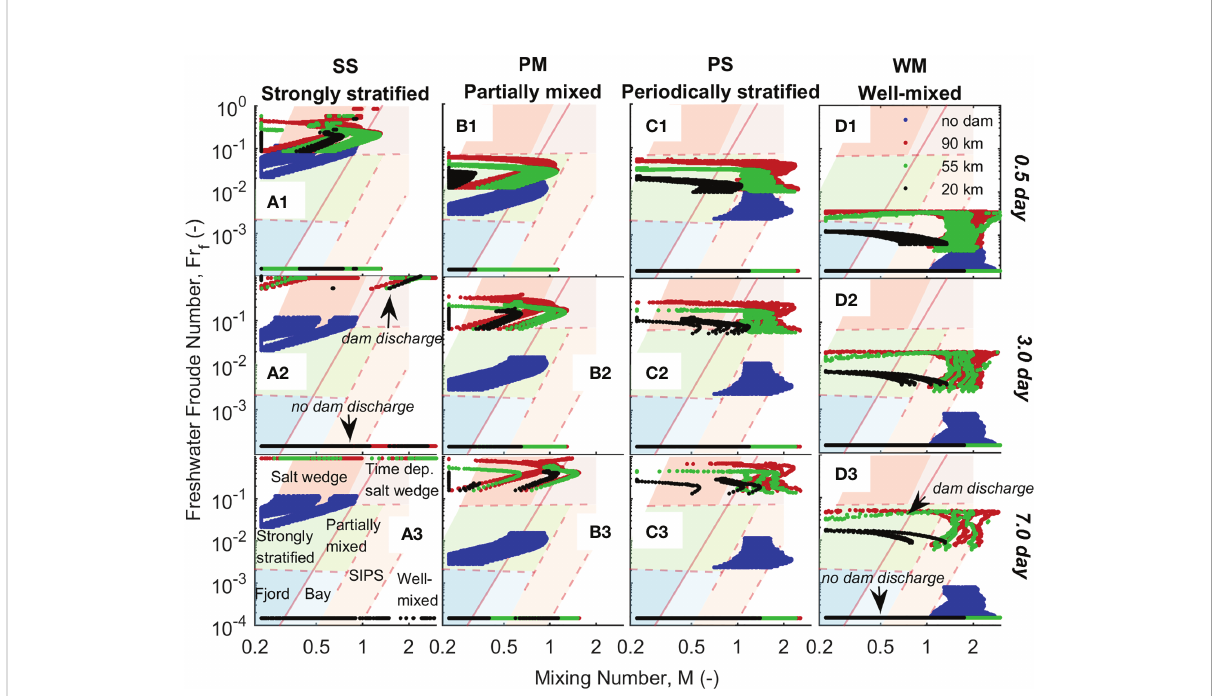
FIGURE 9 Change in estuarine classi fi cation for each estuary type depending on estuarine dam location and discharge interval: (A1-D1) D t = 0.5 day, (A2-D2) D t = 3 day, and (A3-D3) D t = 7 day. Minimum values of M = 0.22 and Fr f = 1.5 × 10 -4 and a maximum value of Fr f = 0.9 were speci fi ed. Physically, these represent very low currents, very low freshwater discharge, and very high freshwater discharge approaching the maximum baroclinic frontal propagation speed, respectively. SIPS is strain-induced periodically strati fi ed estuary, also referred to as a periodically strati fi ed